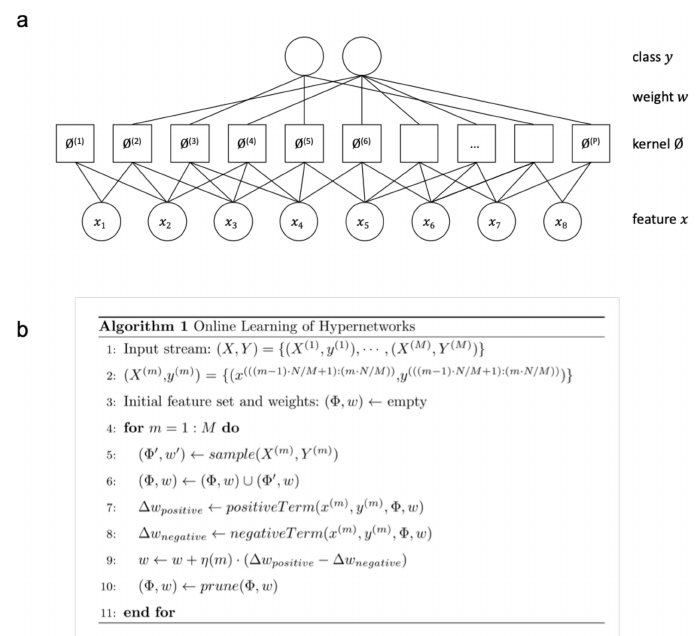
Figure 2. Graphical and algorithmic representation of the hypernetwork model ( a ). The graphical structure of the hypernetwork model. This is the factor graph representation of the model in Figure 1. Note, one kernel corresponds to one factor. ( b ) Algorithm of online learning of